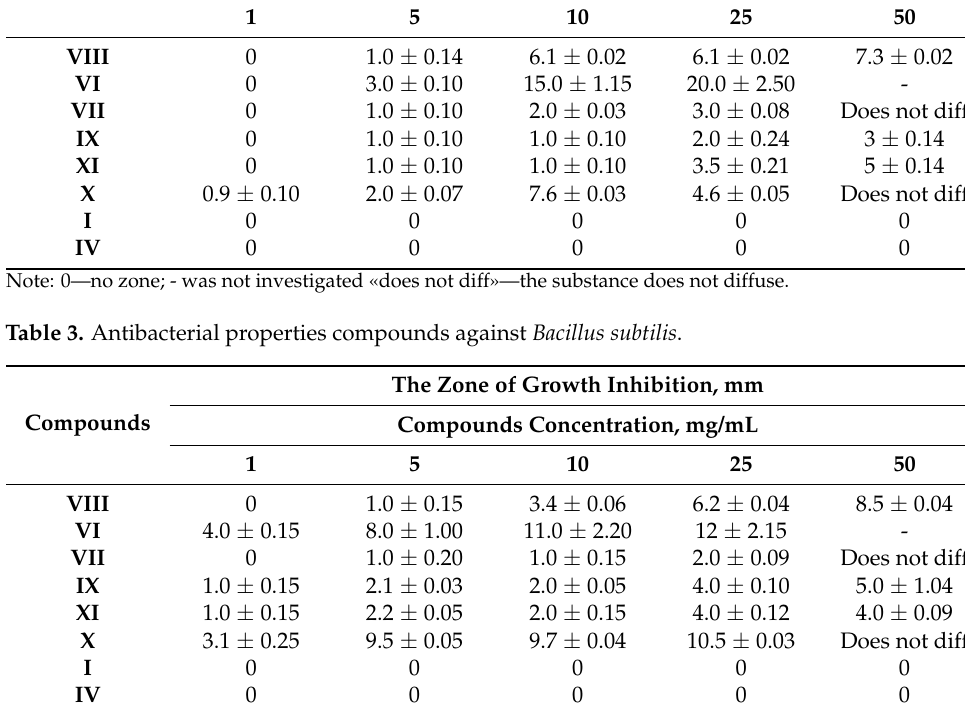
Table 2. Antibacterial properties compounds against Escherichia coli .